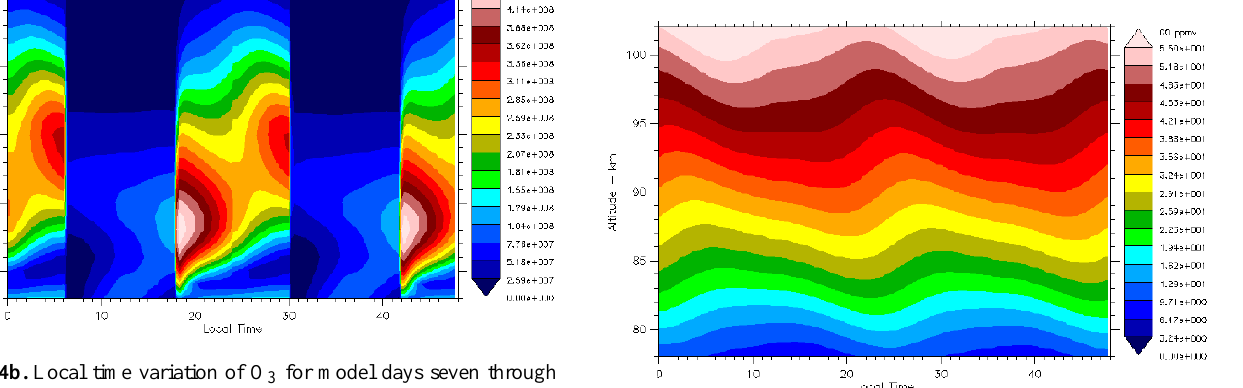
Fig. 4b. Local time variation of O 3 for model days seven through eight in the equatorial region for August. The effects of the diurnal tides are again evident. Note the scale is 1.98 times smaller than in Fig. 4a. The August O 3 densities are approximately one-third the April densities.